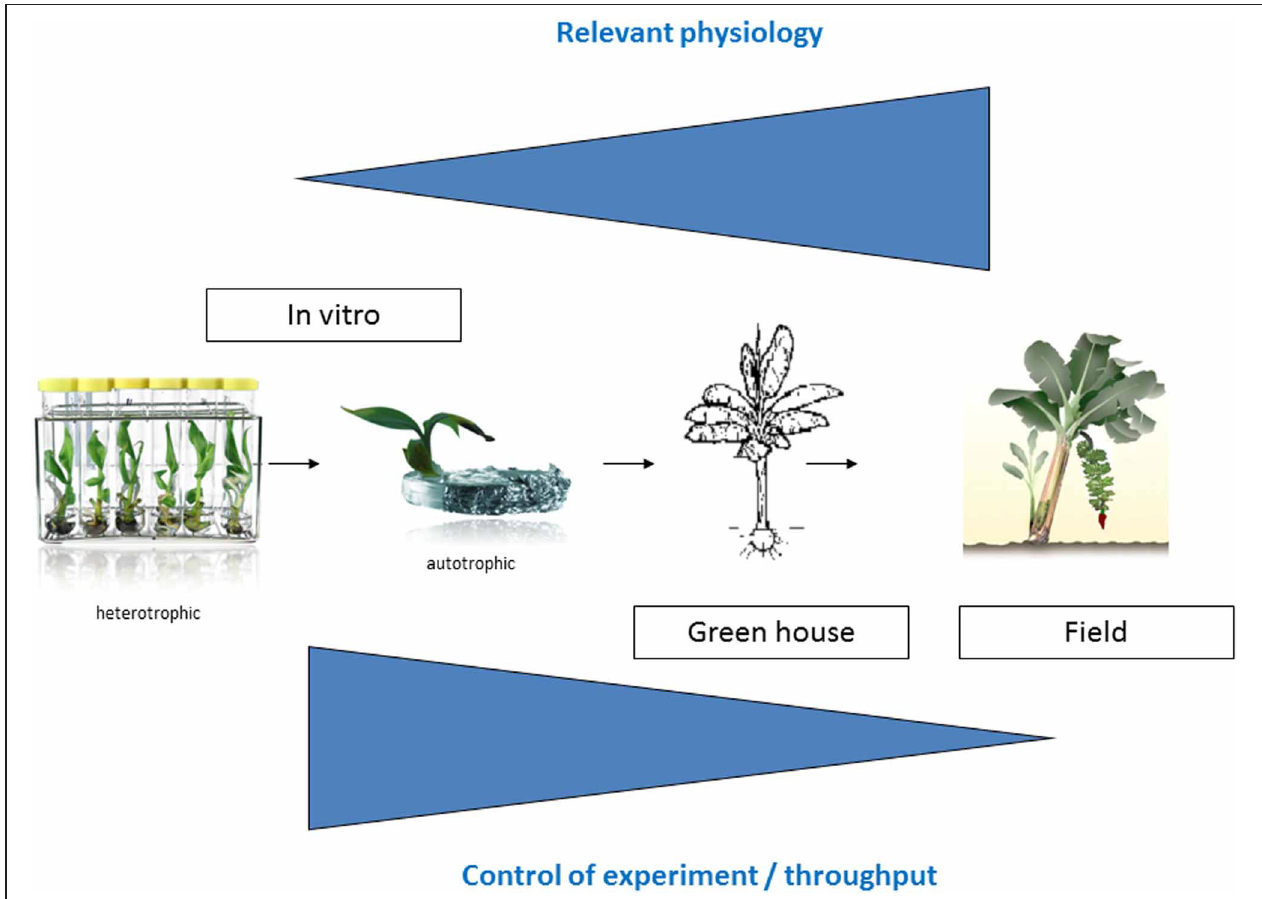
FIGURE 1 | Experimental overview. The closer one gets toward relevant agricultural conditions, the more relevant physiological experiments are, however there is less control of the experiment.